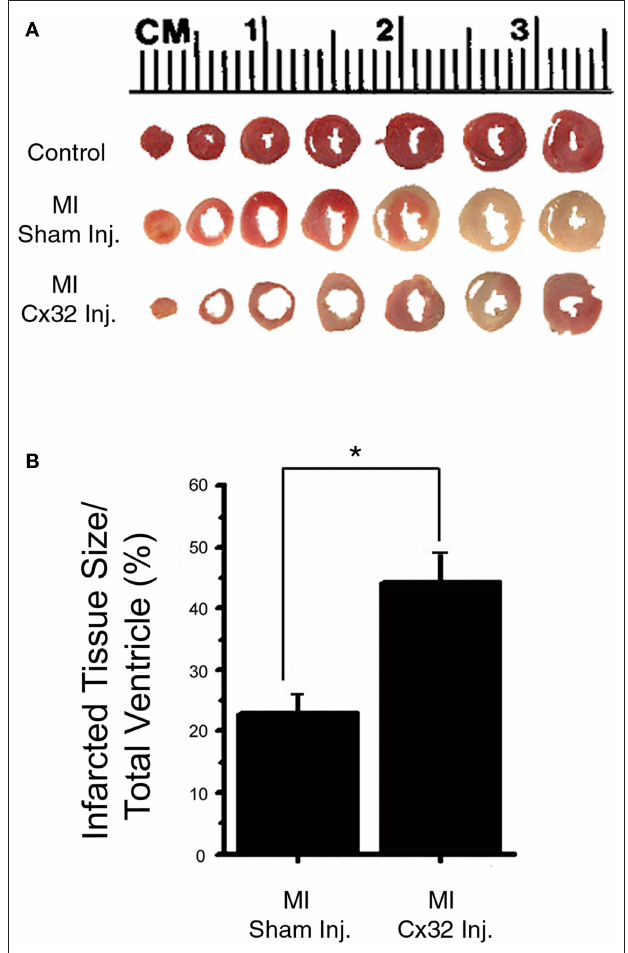
Figure 3 | infarct size analysis. (A) Transverse slices of tetrazolium red-stained wild-type (Control), wild-type with coronary occlusion (MI Sham-Inj), and Cx32 adenoviral vector-injected wild-type with coronary occlusion (MI Cx32 Inj) hearts, depicting volume of infarcted myocardium. Non-infarcted tissue stains red with tetrazolium, whereas infarcted tissue remains unstained. (B) Quantification of infarcted tissue volume shows an increase in infarct size in the Cx32 adenoviral vector-injected wild-type